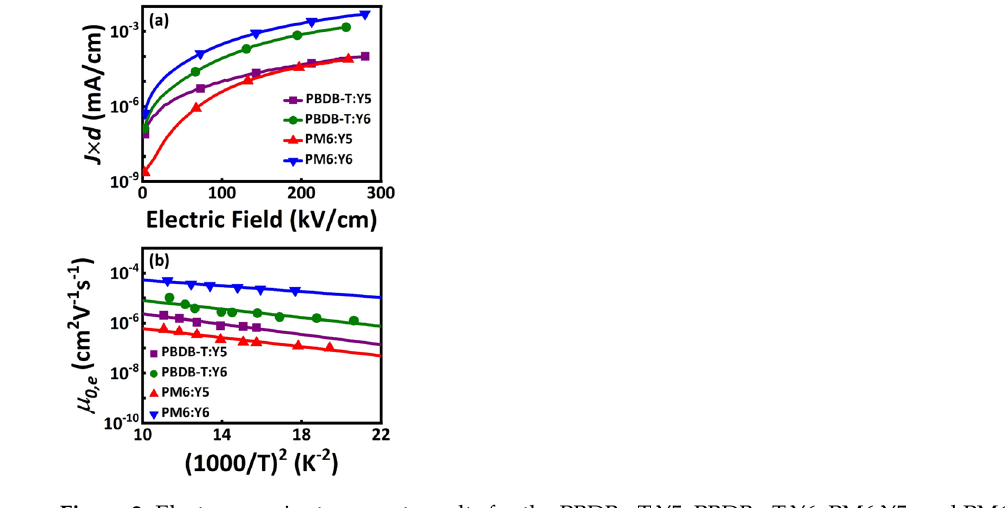
Figure 2. Electron carrier transport results for the PBDB − T:Y5, PBDB − T:Y6, PM6:Y5, and PM6:Y6 BHJ films. ( a ) J × d as a function of the applied electric field; and ( b ) zero − field mobility as a function of (1000/T) 2 .